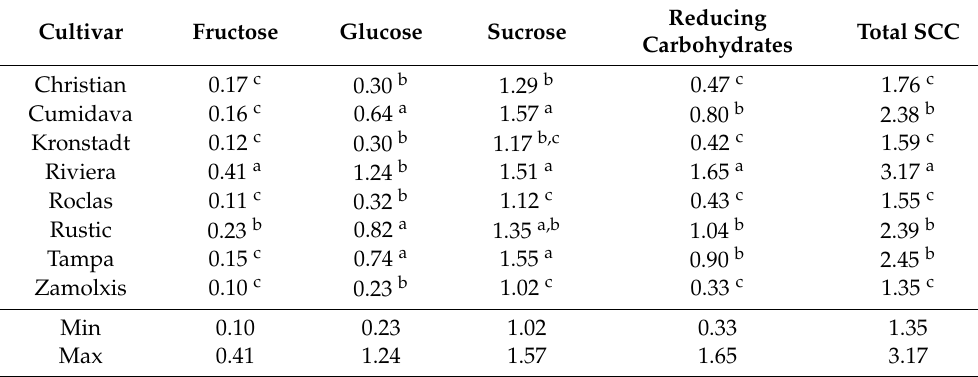
Reducing Total SCC Carbohydrates